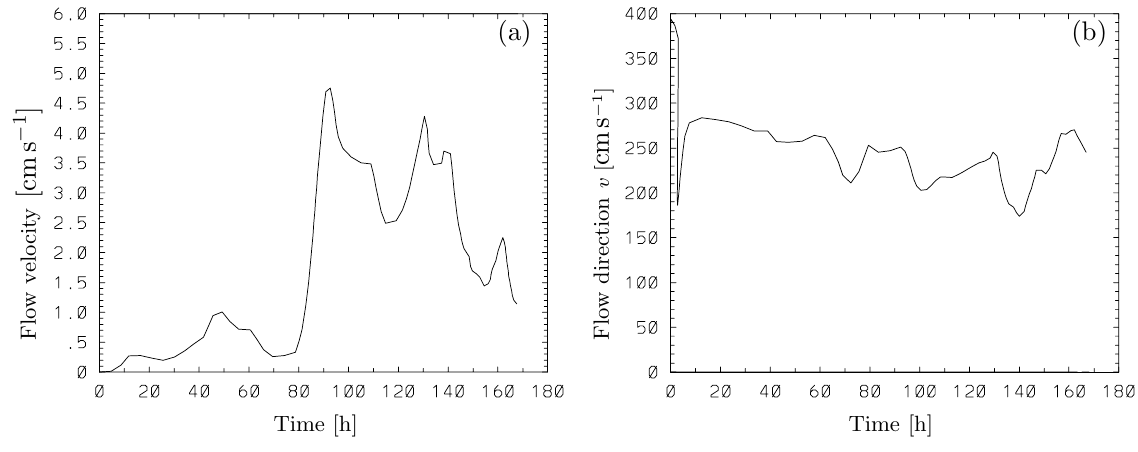
FIG. 25: Time series of the horizontal velocity (a) and its direction (b) at 80 m depth near the Main- auschwelle subject to the wind forcing displayed in Fig. 22. In this computation the Coriolis force is not considered Fig. 25. Time series of the horizontal velocity components (a) u and (b) v at the center of the Obersee subject to the wind forcing of Fig. 22, where the Coriolis force is not considered. The labels indicate the depths in